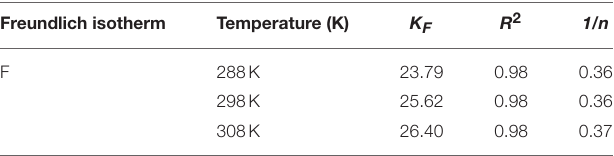
TABLE 4 | Freundlich isotherm parameters for iodine adsorption over JLUE-COP-3. Freundlich isotherm Temperature (K)